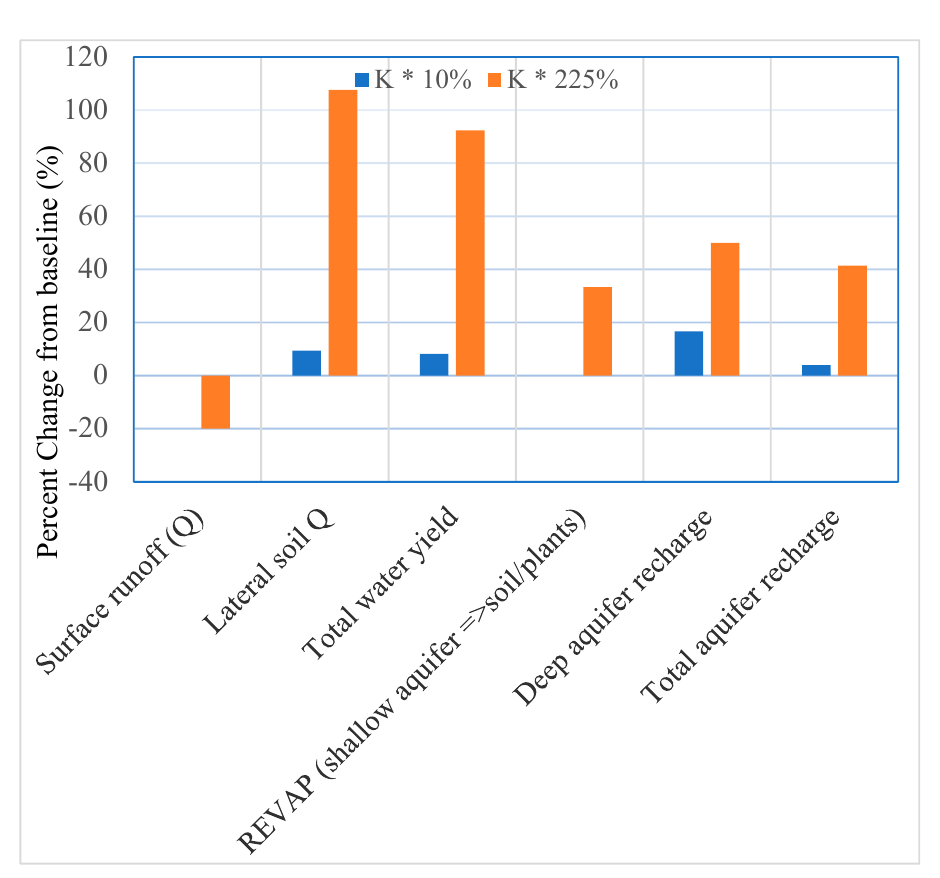
Figure 9. Chart portraying change predictions for water budget in 2050 if gabions are installed throughout the Babocomari Watershed.